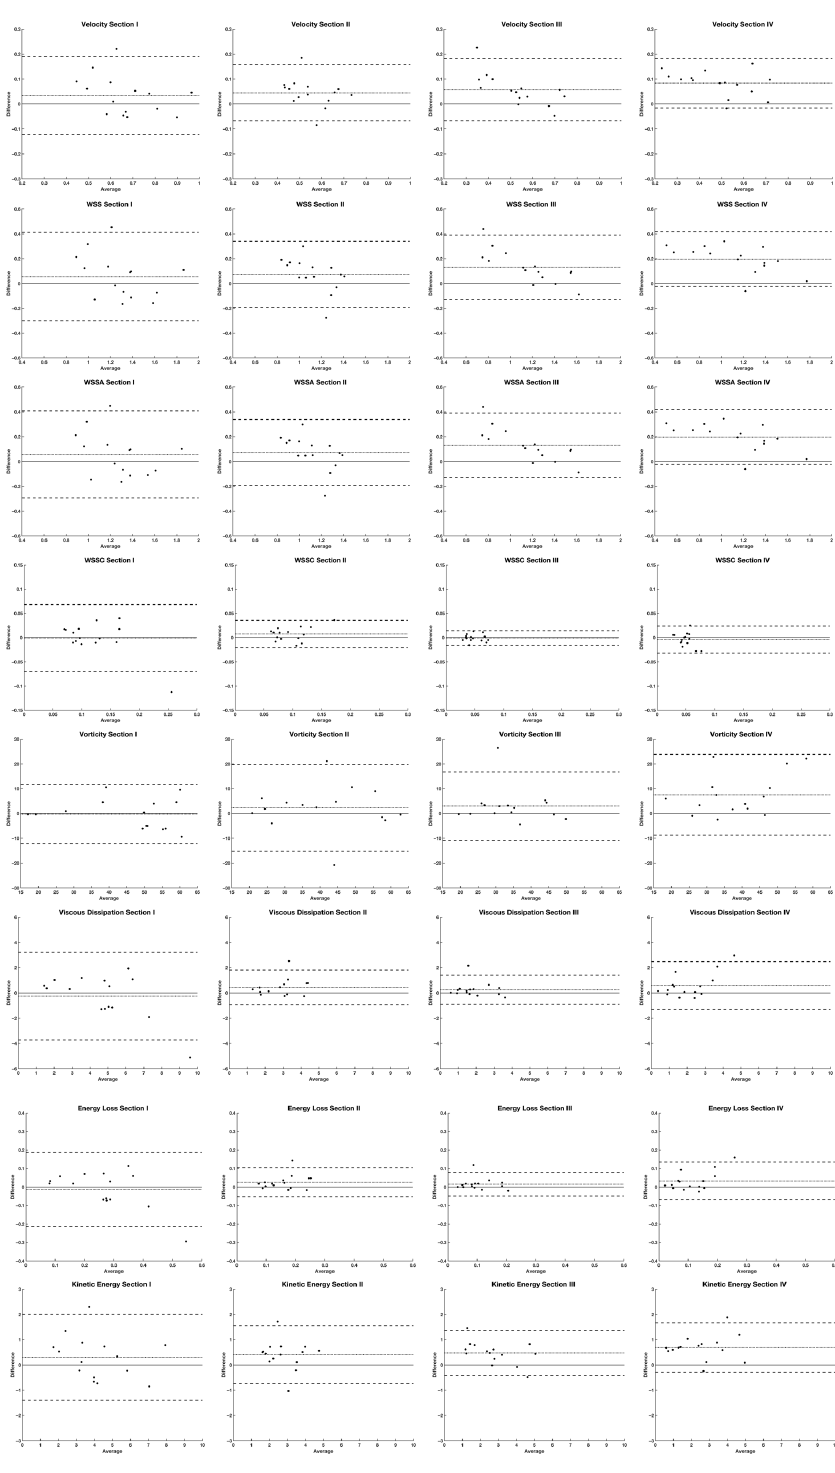
Figure A1. The Bland–Altman plots for comparing the hemodynamic parameters computed in this research, with and without self-gating: velocity; WSS; WSSA; WSSC; vorticity; viscous dissipation; energy loss; and kinetic energy. The average axis of the Bland–Altman plots corresponds to the av- erage of the data with self-gating (SG) and without self-gating (NG), Average = SG + NG . The difference axis corresponds to the difference between the data with self-gating (SG) and without self-gating (NG), Dif ference = SG − NG . The difference axis shows the lines plotting the mean ± 1.96 times the standard deviation, and the zero value for comparison